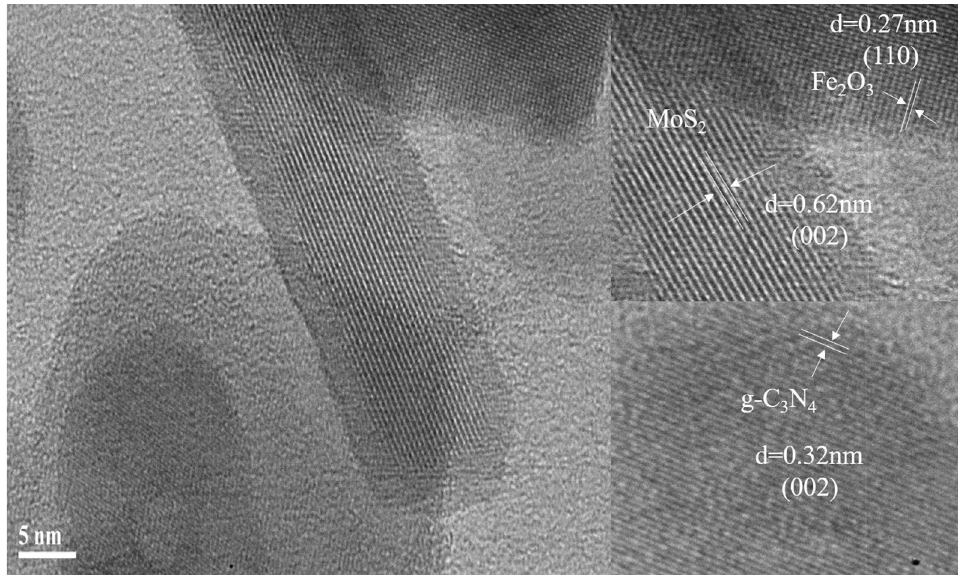
Figure 4. The HRTEM images of MoS 2 /Fe 2 O 3 /CN composite